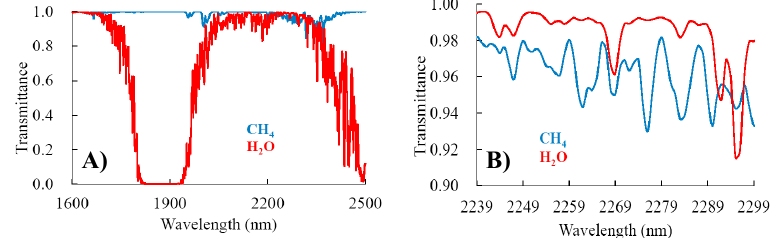
Figure 4. Transmittance spectra for H 2 O and CH 4 in wavelength ranges of (A) 1600–2500 nm, (B) 2239–2299 nm, generated using MODerate resolution atmospheric correction TRANsmission (MODTRAN) for a mid-latitude summer atmosphere for the AVIRIS-NG sensor (Figure 2) at 2.4 km altitude with CH 4 based on in situ data, see Figure 3.